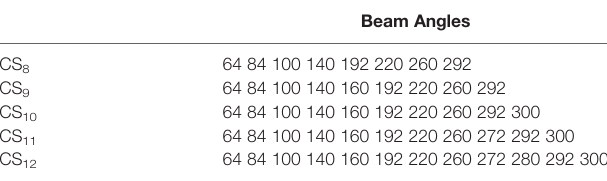
TABLE 1 | Beam angle con fi gurations of the different CS x based on all 23